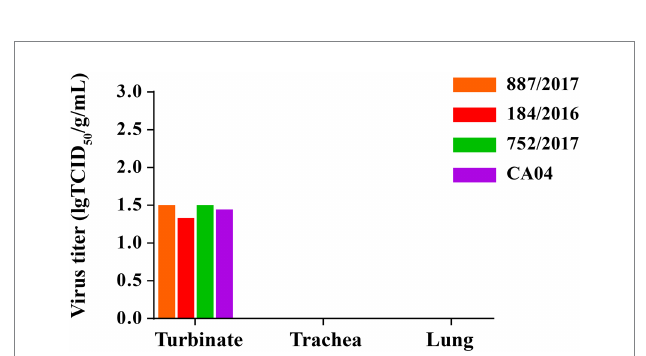
FIGURE 5 Replication of 887/2017, 752/2017, 184/2016 and CA04 viruses in guinea pigs. Eight female, 6-week-old, SPF, Hartley strain guinea pigs were randomly divided into four groups and each group includes 2 guinea pigs. Groups of guinea pigs were intranasally inoculated with 887/2017, 752/2017, 184/2016, and CA04 at a dose of 10 6 TCID 50 in 300 μ L under anesthesia, respectively. Guinea pigs were necropsied at 3 DPI, and turbinate, trachea, and lung were collected. The viral titers in tissues of guinea pigs were titrated in MDCK